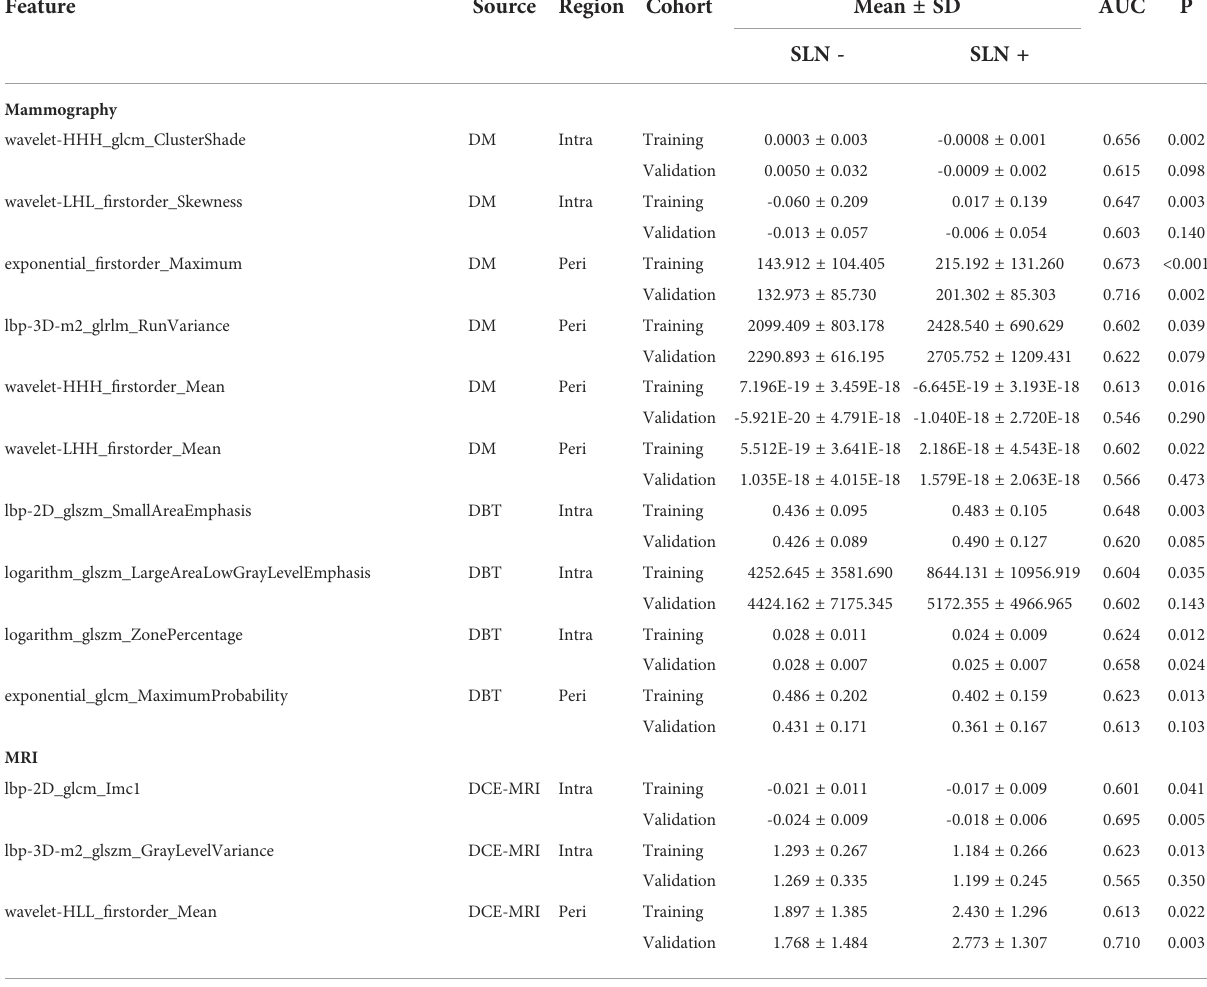
TABLE 4 The selected most important features from mammography and